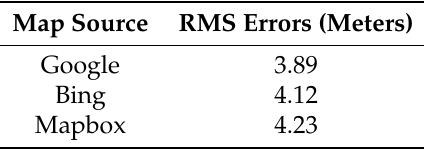
Table 1. Accuracy of the online aerial maps, i.e. , root mean square (RMS) values of the positioning errors according to our GPS survey